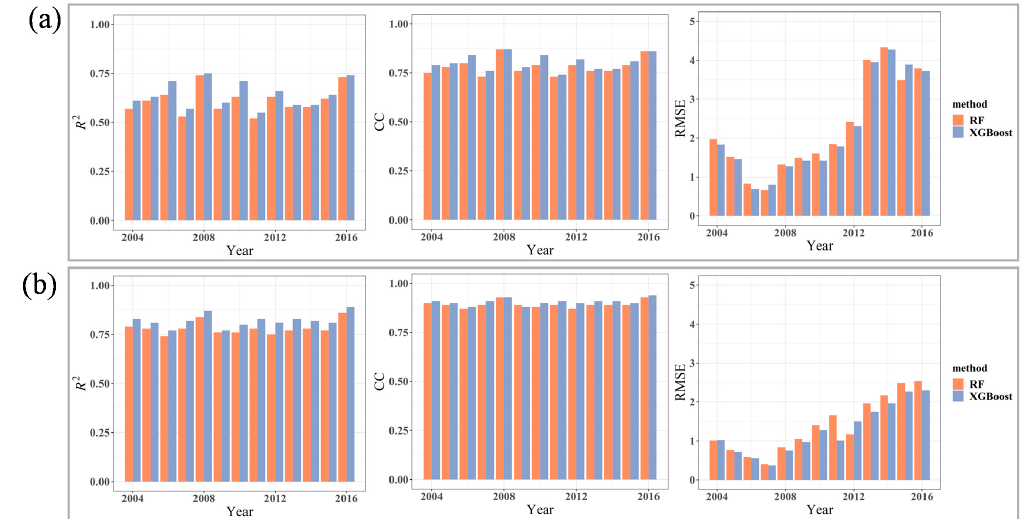
Figure 4. R2, CC and RMSE metrics of the RF-modeled and XGBoost-modeled TWS based on ( a ) CSR-MS.906 clusters and ( b ) CSR-SH data.